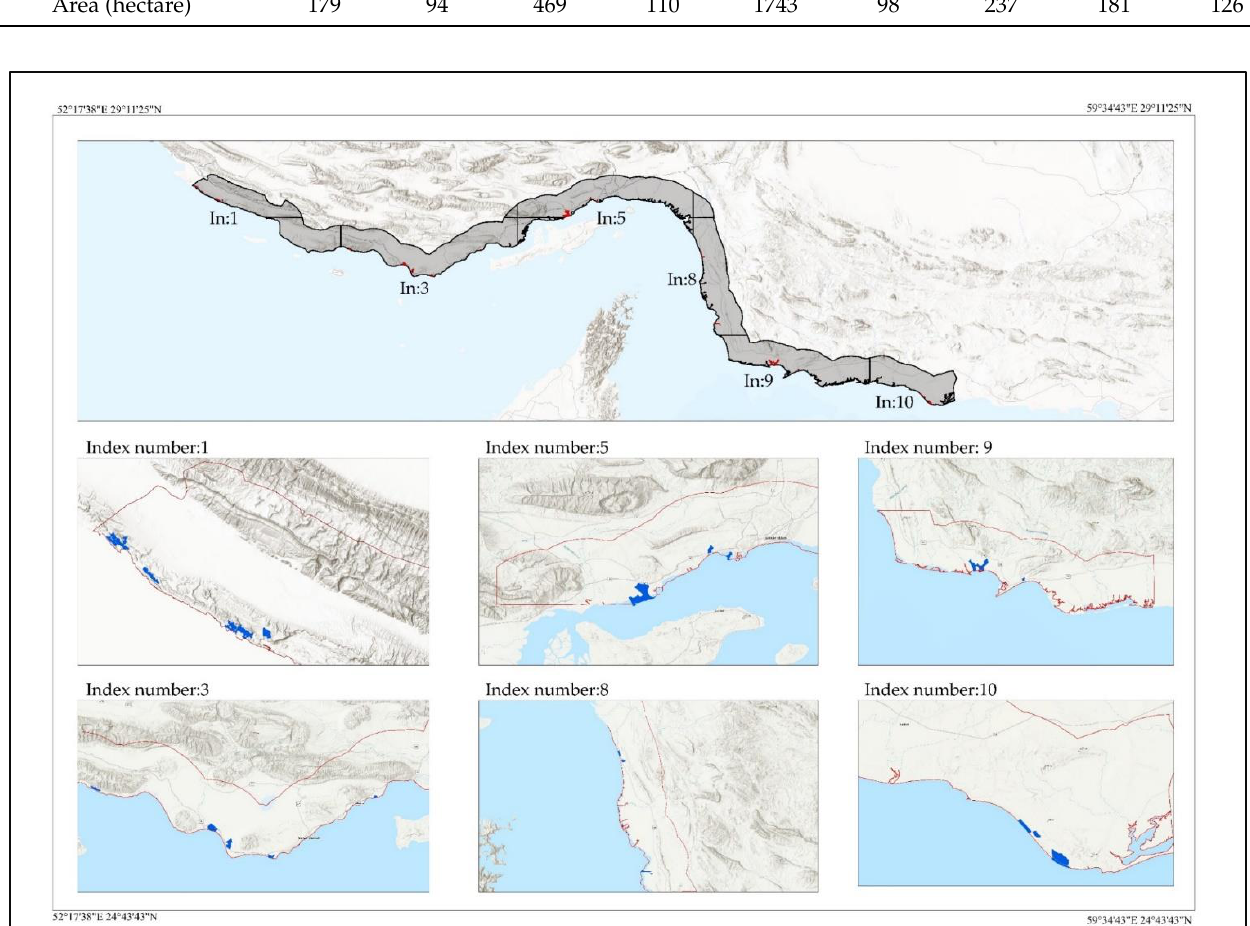
Figure 6. Selected sites in the region.